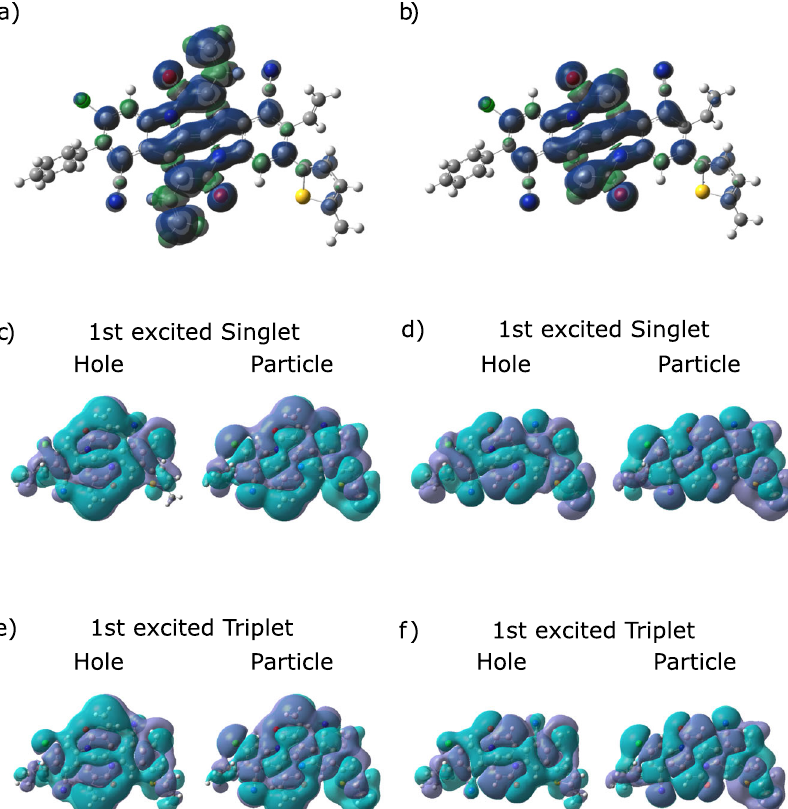
Fig. 3 Wavefunction properties of the fi rst excited triplet and singlet states of two molecules. Spin densities of the fi rst excited triplet state of a CIBA Vi and b CIBA Hyd . Hole and particle wavefunctions of the fi rst excited singlet state of c CIBA Vi and d CIBA Hyd . Hole and particle wavefunctions of the fi rst excited triplet state of e CIBA Vi and f CIBA Hyd . Note that the latter NTOs depict the nature of the spin-forbidden S 0 to T 1 transition and were obtained through considering a formally spin-free one-particle transition density matrix. All surfaces were created with an isosurface density of 0.0004 using GaussView 64 . Natural transition orbitals (NTOs) were calculated from the Gaussian output using the ORBKIT programme package 65 – 67 .